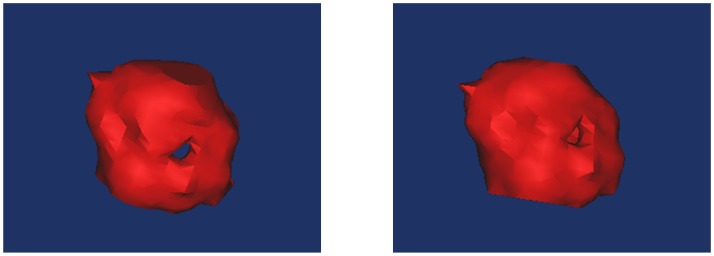
3D reconstruction of a cavitary nodule.